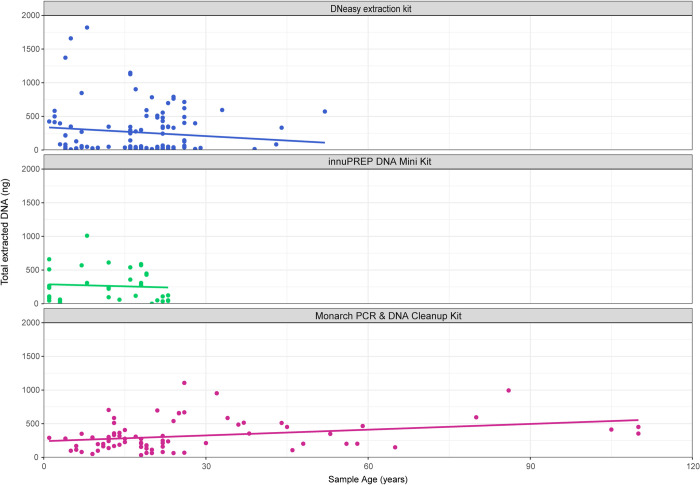
Distribution of the total extracted DNA from the three kits.(A) samples extracted with the DNeasy extraction Kit (Qiagen); dots in green are the samples extracted using the innuPREP DNA Mini Kit (Analytik Jena), and the dots in magenta are samples extracted with the Monarch® PCR & DNA Clean-up Kit (New England Biolabs). A trend line was included for each protocol for visualisation of overall distribution.